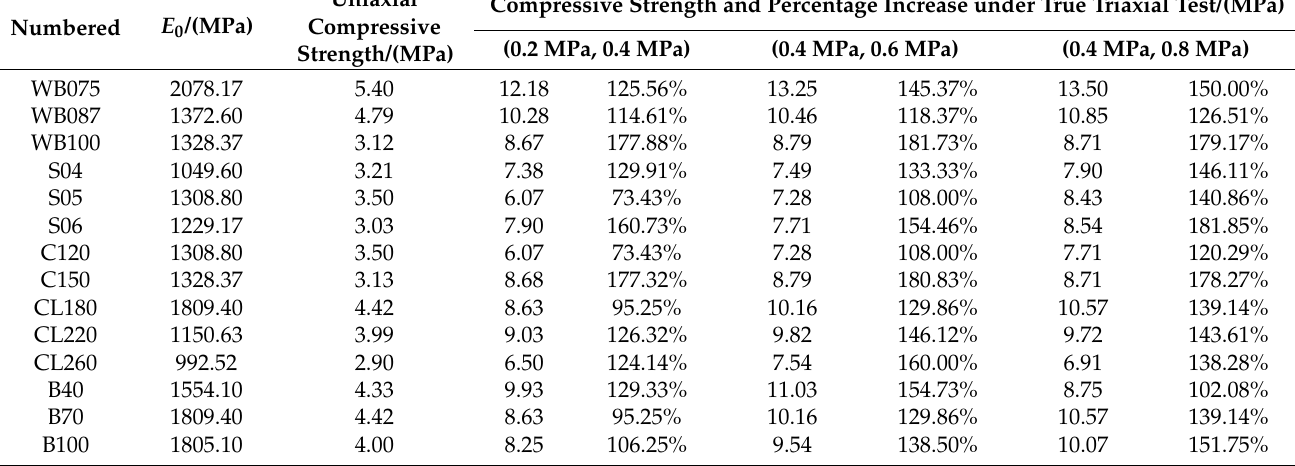
Table 4. Summary of the results of the uniaxial compressive and true triaxial compressive tests. Uniaxial Compressive Numbered E 0 /(MPa) Strength/(MPa)